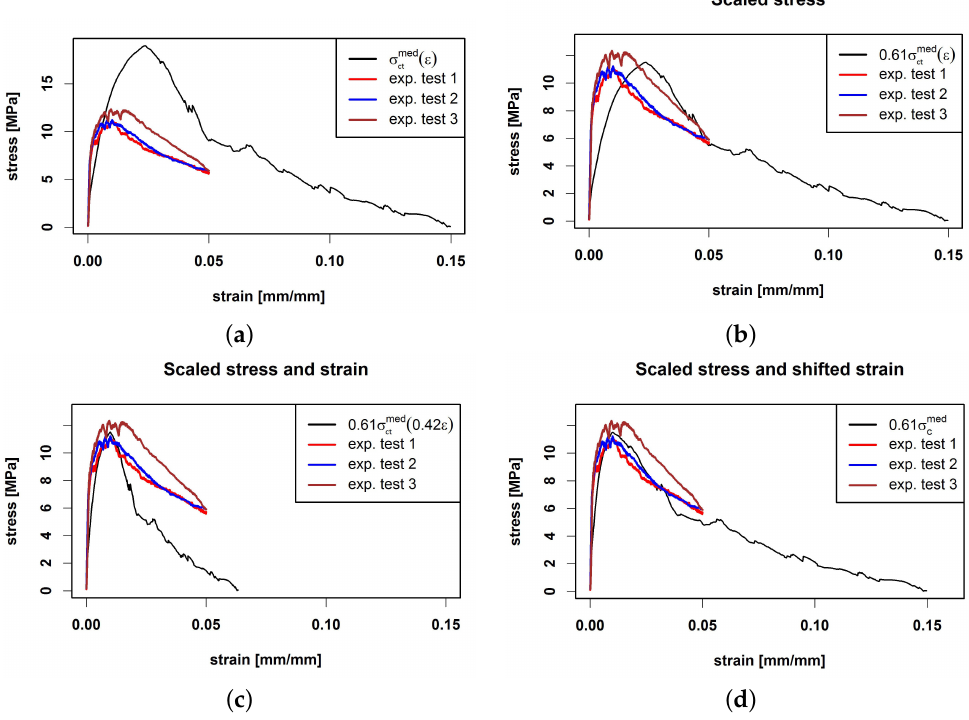
Figure 8. Prediction of composite stress σ ct ( ε ) by σ med ( ε ) by stress scaling factor S σ tensile curves. Scaled σ med ct = 0.42 ( c ). ( d ) Prediction based on Equation strain scaling factor S ε ult